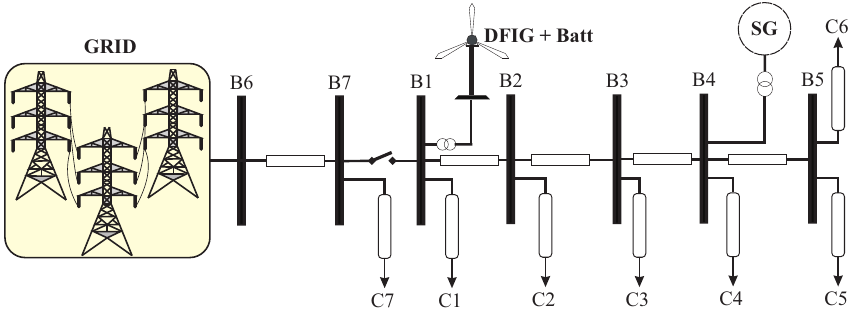
Figure 6. General distribution